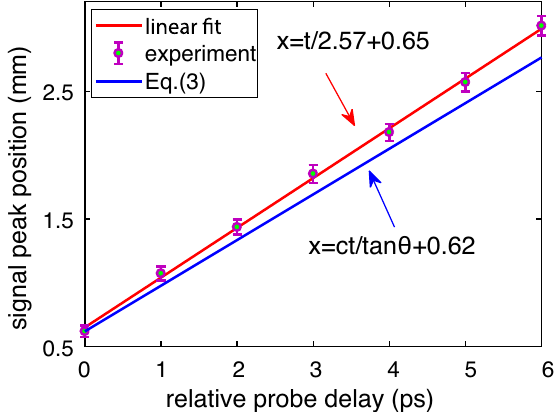
FIG. 5. Measurements and theoretical calculations of the temporal mapping relationship. The mean positions are denoted by green dots and standard deviations are denoted by error bars. The red solid line denotes a linear fitting of the experimental results, while the blue solid line illustrates the numerical calculations by Eq. (3).